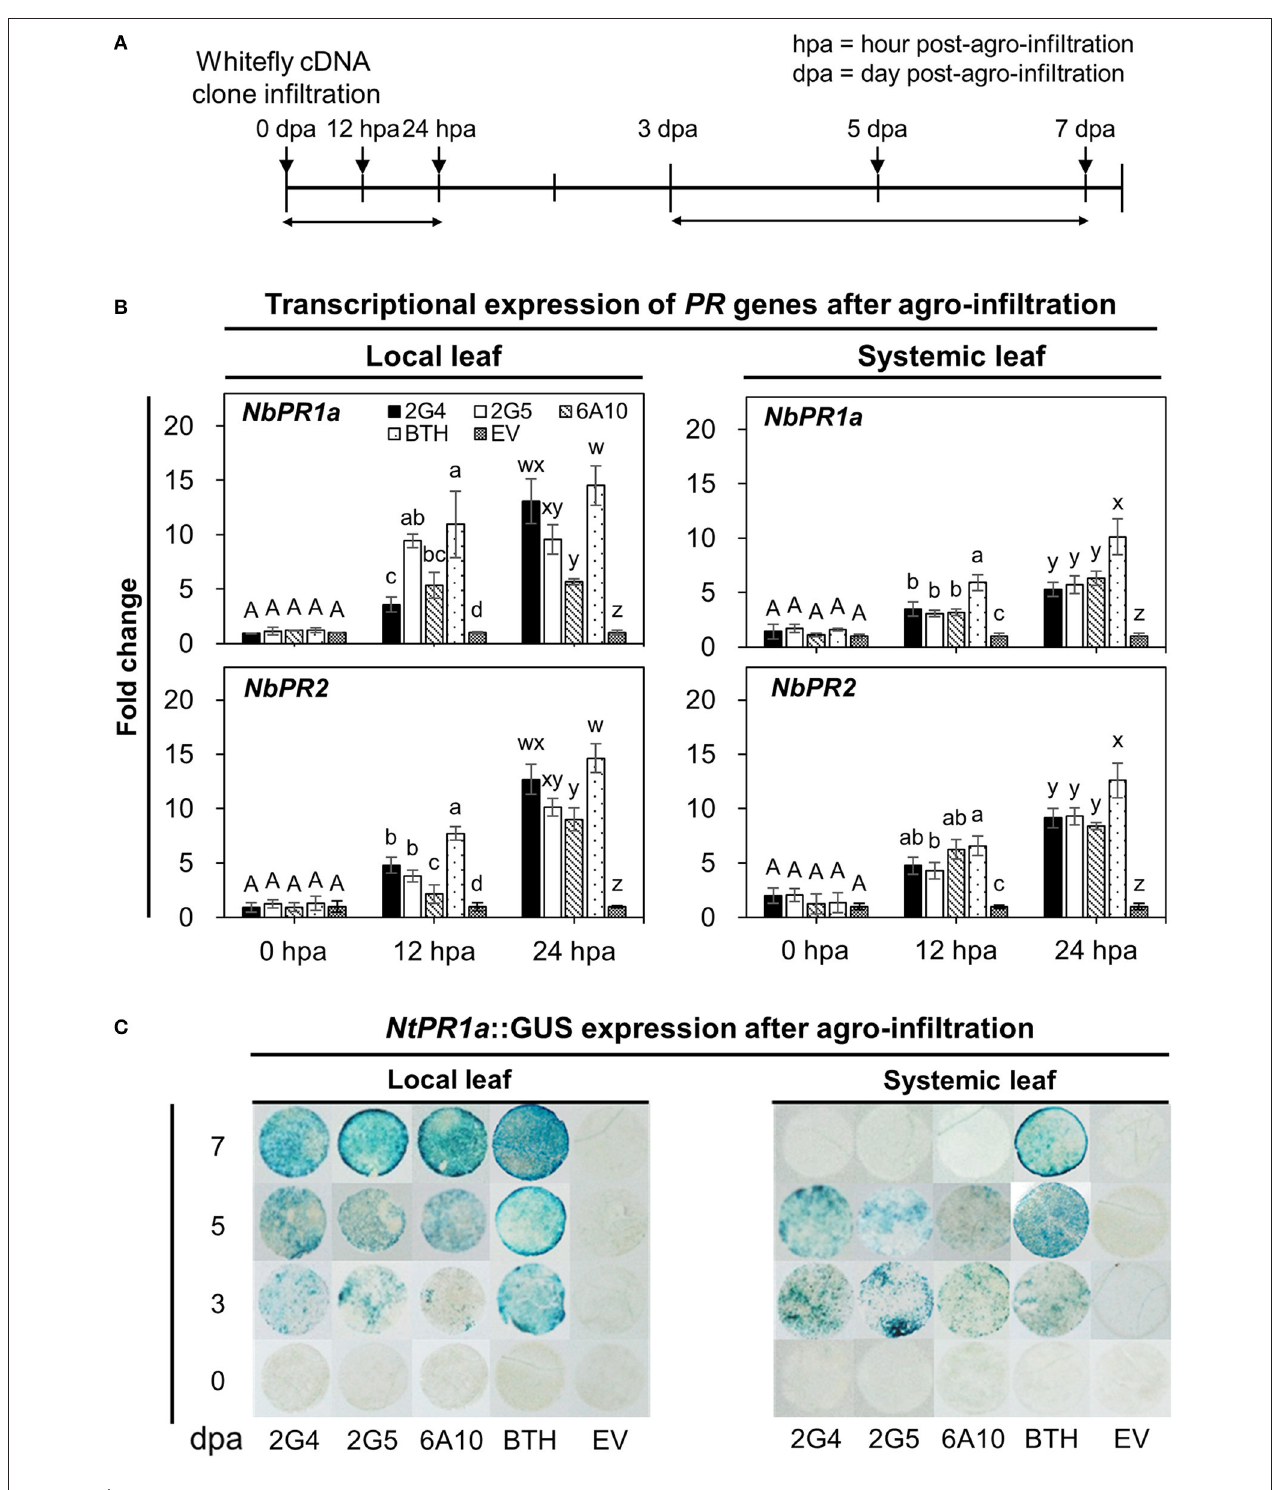
FIGURE 3 | Whitefly effector-mediated early and late expression of SAR marker genes in N. benthamiana . (A) Schematic diagram of the experimental design for investigating the expression of marker genes ( NbPR1a , NbPR2 ) and the staining of leaf disc from NtPR1a::GUS transgenic tobacco after leaf infiltration with whitefly cDNA clones 2G4, 2G5, and 6A10 and empty vector (EV). The samples used for the early gene expression were local and systemic leaves after whitefly cDNA clone leaf-infiltration at 0, 12, and 24h post- Agrobacterium infiltration (hpa). The samples for GUS staining to late expression of a SAR marker gene were leaf disc collected at 3, 5, and 7 days post- Agrobacterium infiltration (dpa). (B) Quantification of defense priming of SAR marker genes NbPR1a and NbPR2 in plants at 0, 12, and 24h